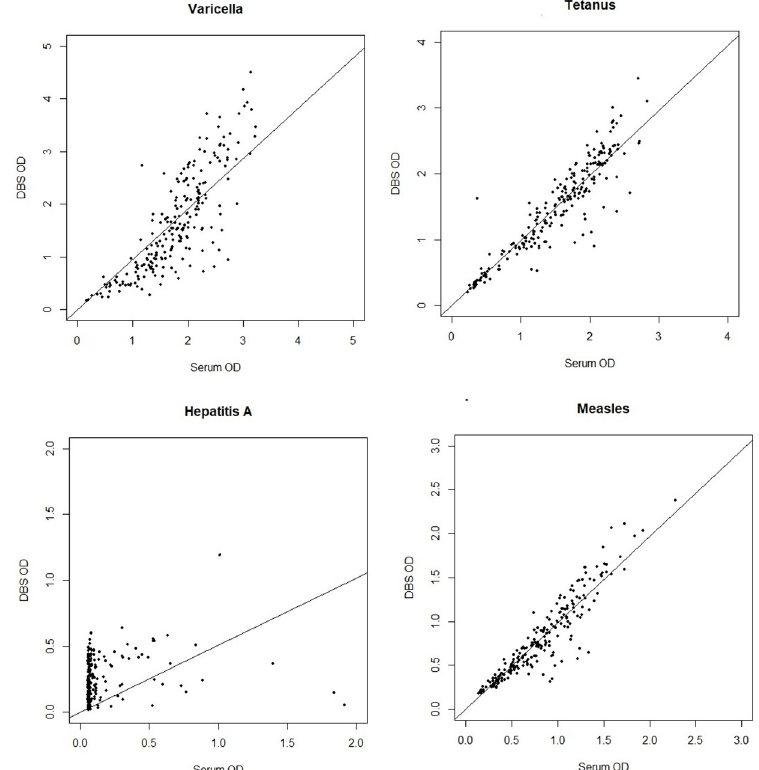
Fig 2. Correlation of IgG antibody levels detected by DBS sampling to IgG antibody levels detected by serum sampling for measles, hepatitis A, tetanus and varicella zoster.